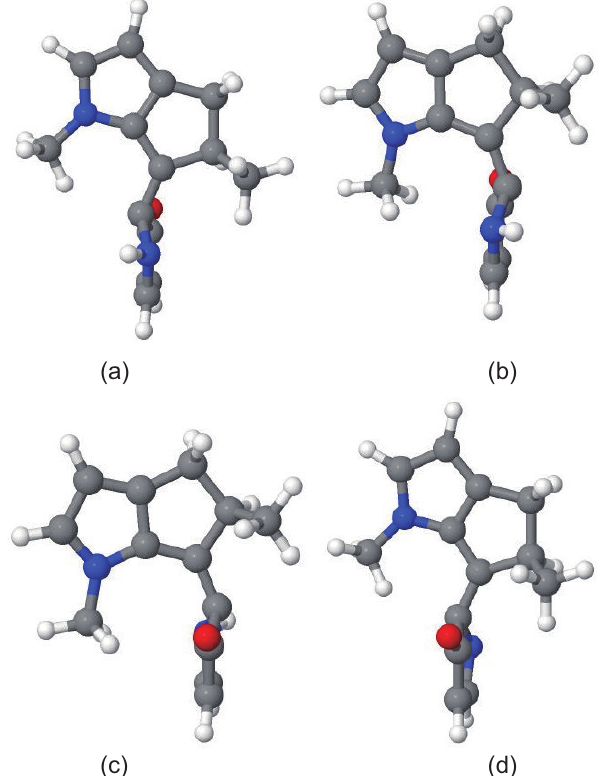
Figure 4. Optimized geometries of four S 1 /S 0 conical intersections ( a ) ECI(1), ( b ) ECI(2), ( c ) ZCI(1), and ( d ) ZCI(2) in the EP → ZP and ZP → EP photoisomerization processes calculated with the OM2/MRCI method implemented in the MNDO99